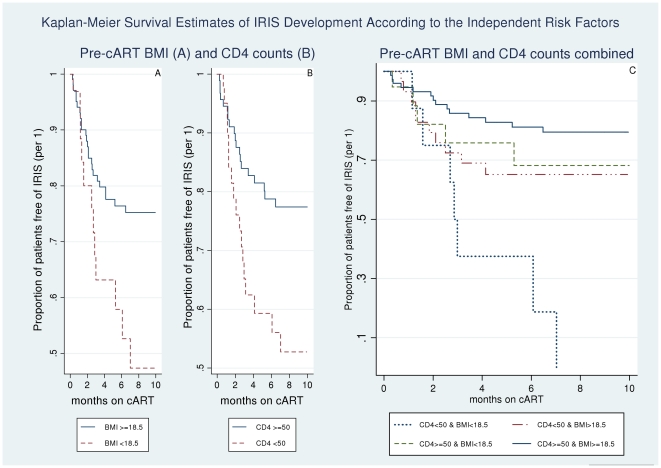
Kaplan Meier Survival estimates of IRIS development by the independent predictors identified.Kaplan Meier survival estimates of immune reconstitution inflammatory syndrome (IRIS) development according to the two independent predictors identified: pre-cART body mass index (A), pre-cART CD4 count (B), and the combination of both risk factors (C).